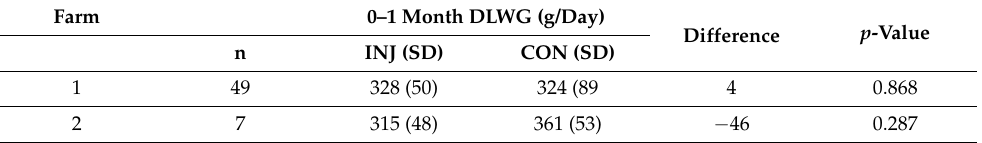
Table 5. Overall DLWG in lambs, 0–1 month, singles